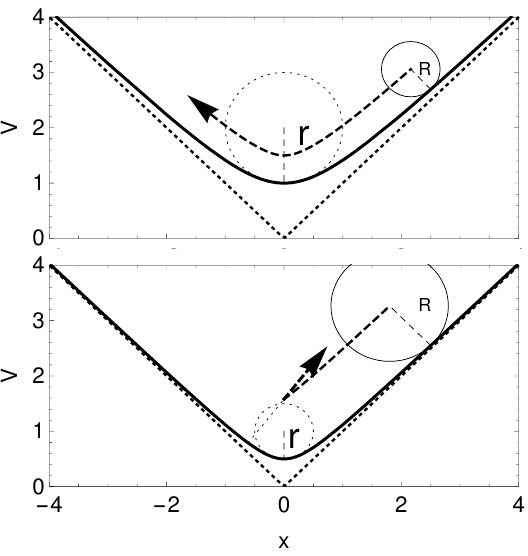
Figure 1 . Classical motion of a ball with a finite radius R in the regularized potential (2.3) with u = 1 , which is characterized by the radius of curvature r at x = 0 , visualized by the dotted osculating circle. The motion of the ball depends on the ratio r/R . If r/R (cid:29) 1 , then the ball can smoothly roll to the other side (top panel), while if r/R (cid:28) 1 , then it hits the other side of the potential (considering it as a hard surface) and might bounce up (bottom